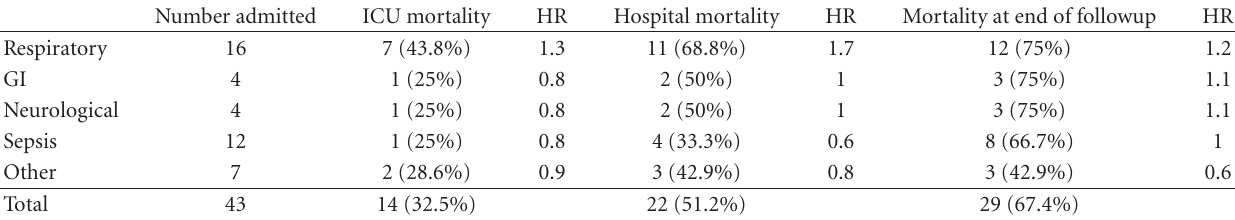
Table 2: Primary reasons for ICU admission and outcomes. Numbers are absolute values (percentage). HR: hazard ratio for death in that group. All 95% confidence intervals for hazard ratios overlap 1.